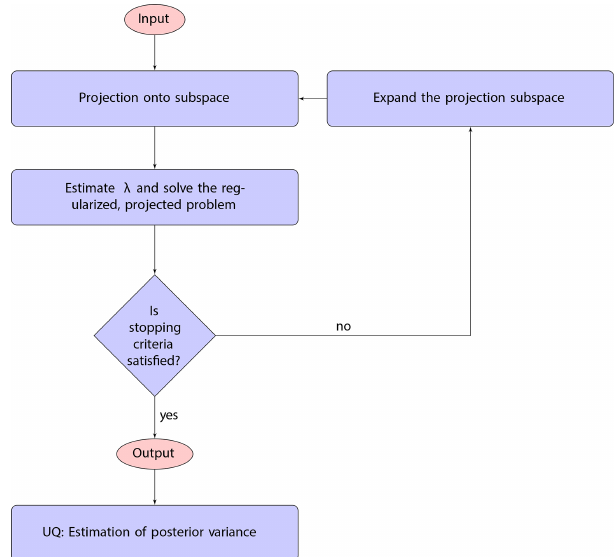
Figure 1. This flowchart provides a general overview of using gen- HyBR methods for AIM and subsequent UQ. Given input (corre- sponding to the observations and details of the problem setup), gen- HyBR is an iterative approach to approximate the MAP estimate. Each iteration of genHyBR consists of expanding the solution sub- space (Sect. 3.1.1), projecting the problem, estimating a regulariza- tion parameter (Sect. 3.1.2), and solving a projected, regularized problem. After obtaining the MAP estimate, information computed from genHyBR can be used to efficiently estimate the posterior vari- ance for UQ (Sect.